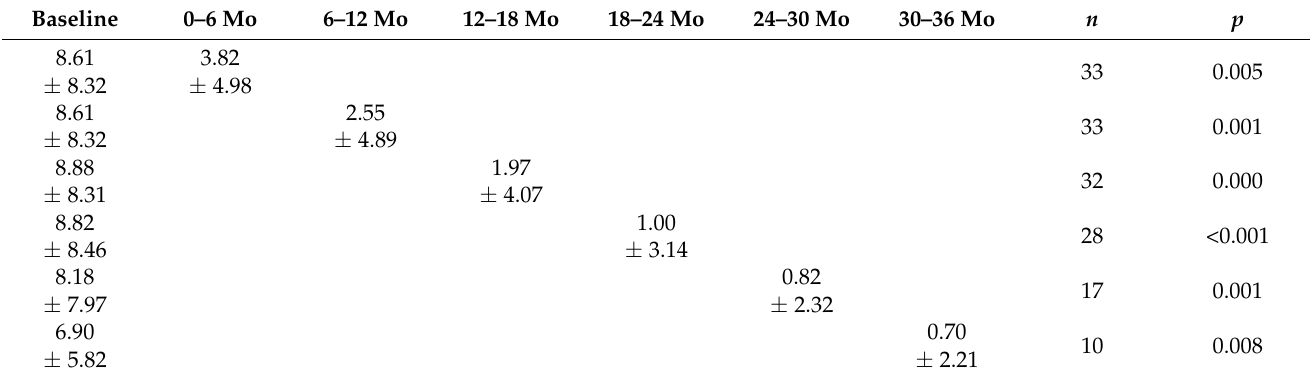
Table 4. Dosage of oral antibiotics (days) (paired t-test).